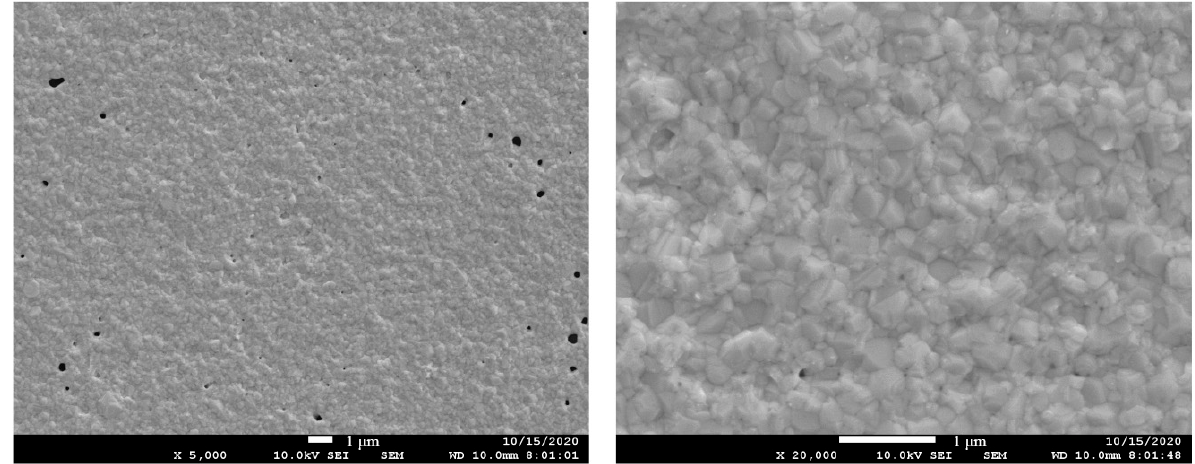
Figure 8. SEM images of the sintered line, demonstrating the degree of sintering and the polycrystalline structure of the end material.